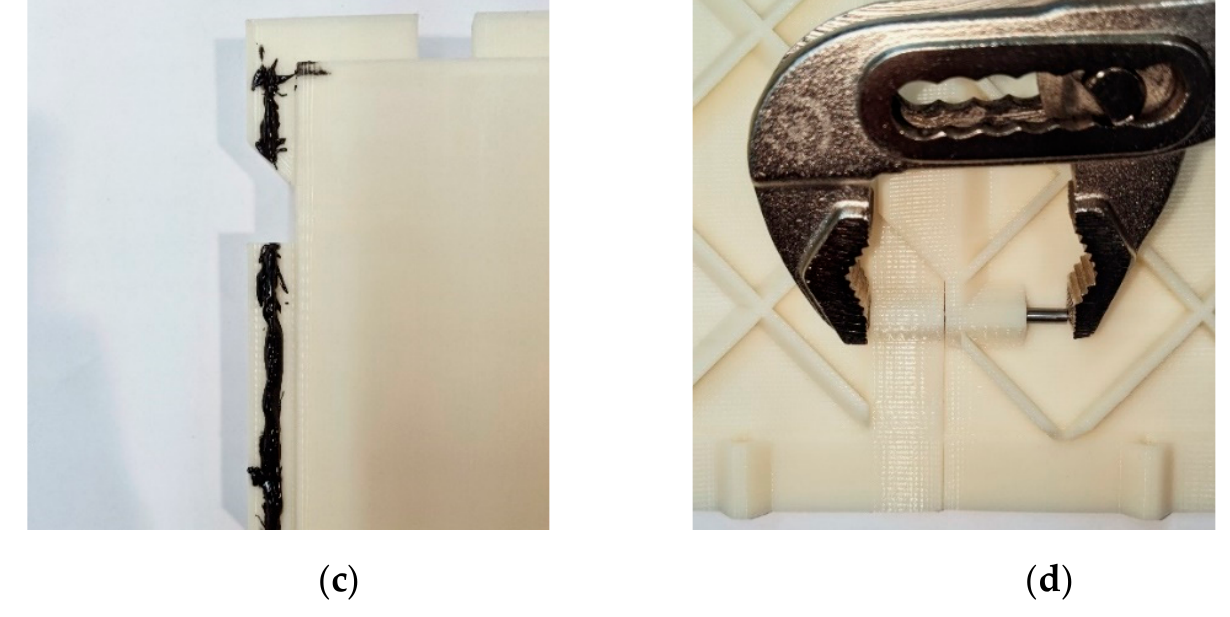
Figure 19. Assembly procedure for two segments. ( a ) Reaming the pin holes; ( b ) countersinking the pins; ( c ) applying the adhesive; ( d ) aligning the segments and fitting the pins.